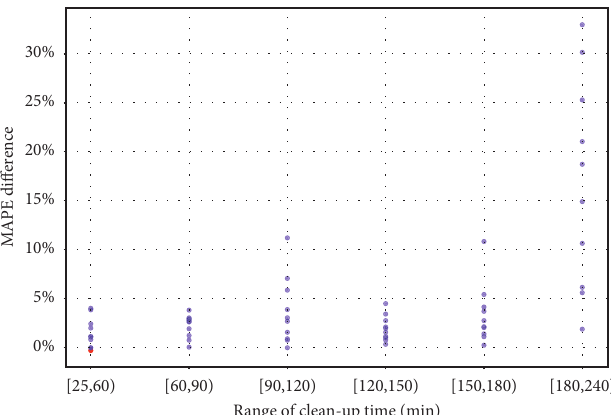
Figure 17: MAPE difference distribution of full-recovery time.